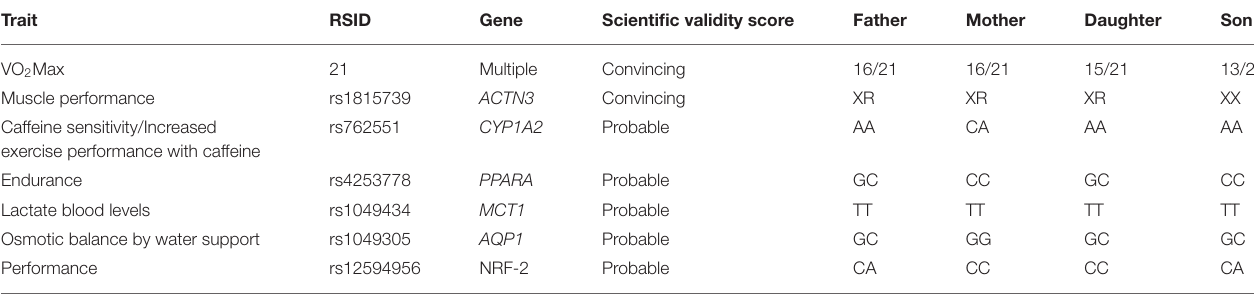
TABLE 6 | Summary of fitness trait analysis for 4 family members.